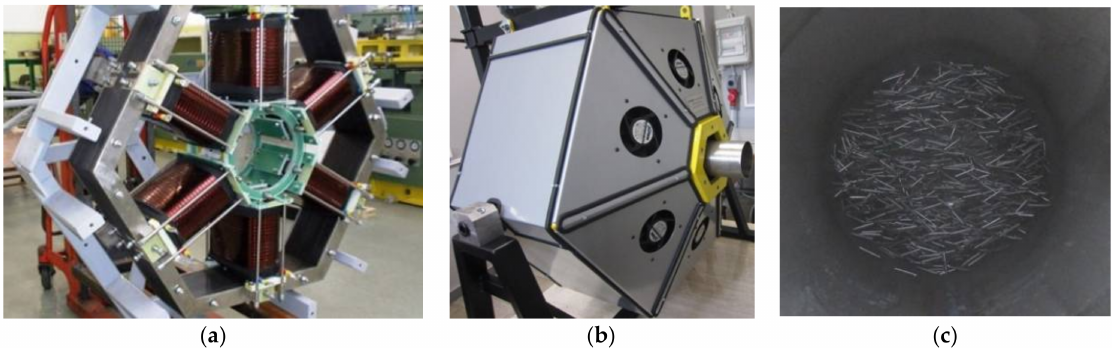
Figure 1. Electromagnetic mill, ELTRAF. Electromagnets ( a ); The mill with the cover and working tube ( b ); and, Working chamber with the grinding media during operation ( c